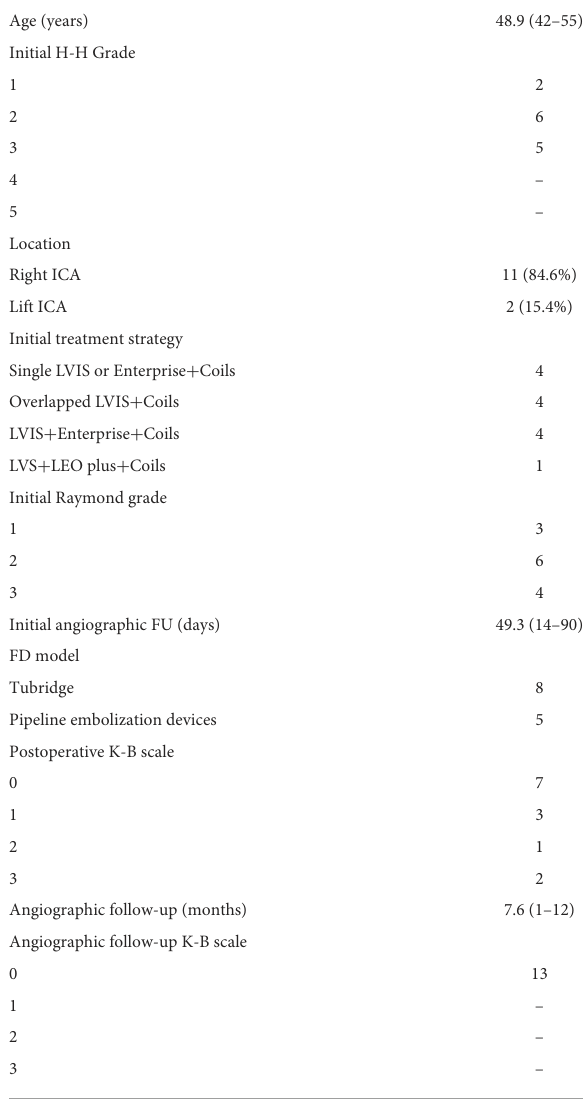
TABLE 1 Clinical data of all the